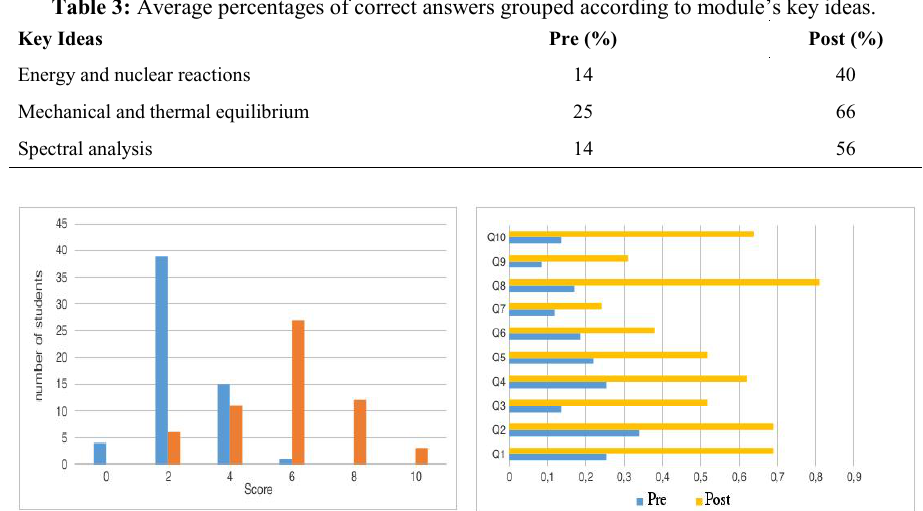
Fig. 4. Students’ score distribution in the pre- and post-activity questionnaire